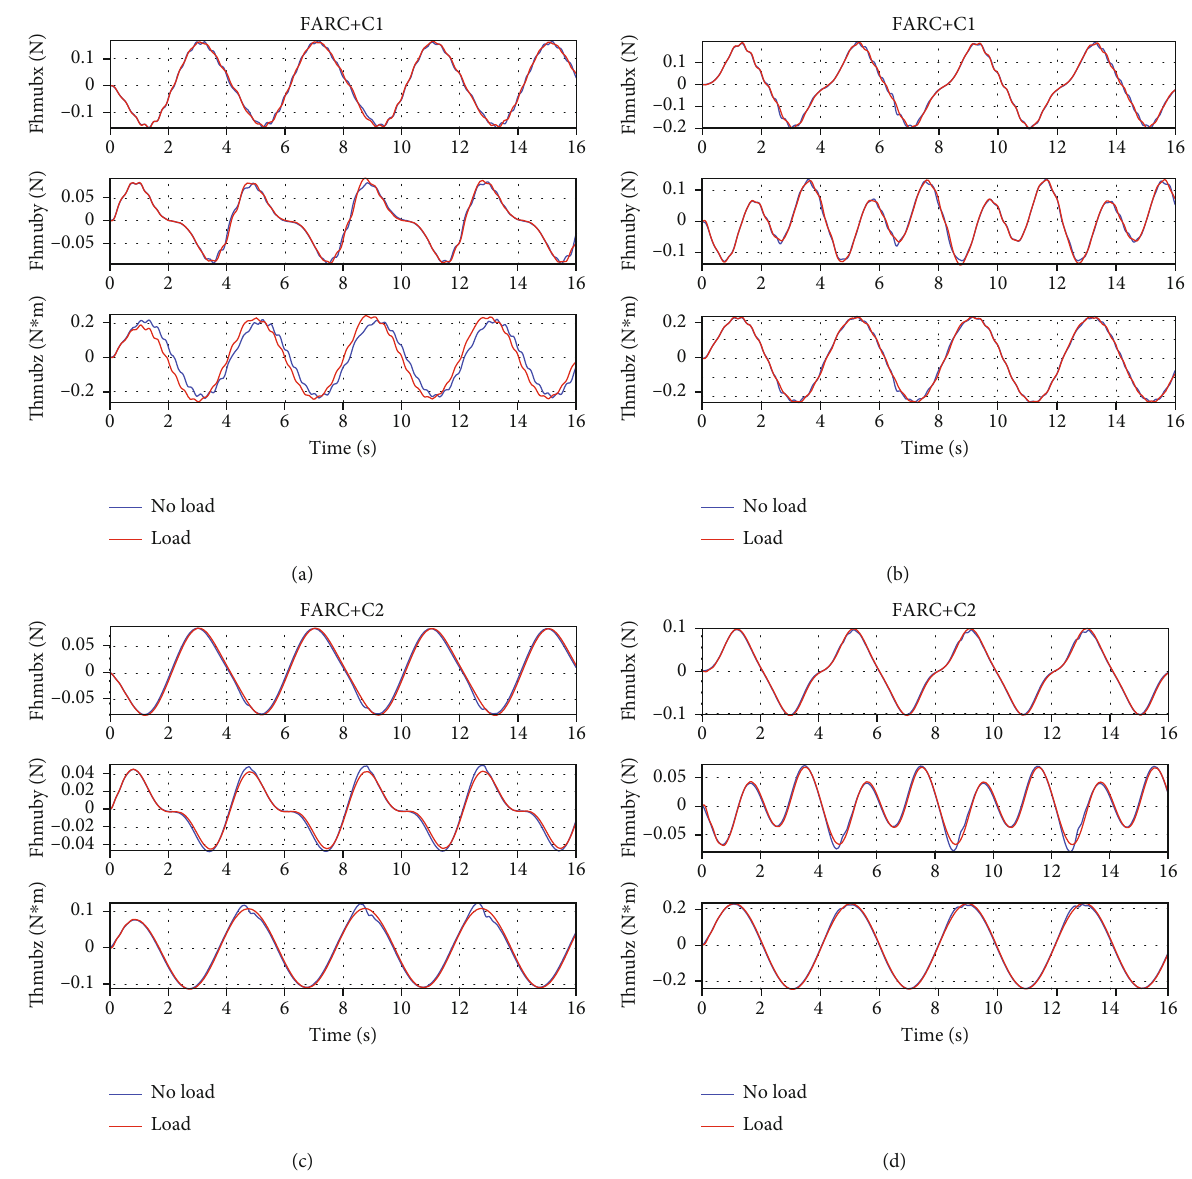
Figure 9: Human-machine interaction force of left leg support for Set3: (a) at the back for FARC+C1, (b) at the right foot for FARC+C1, (c) at the back for FARC+C2, and (d) at the right foot for